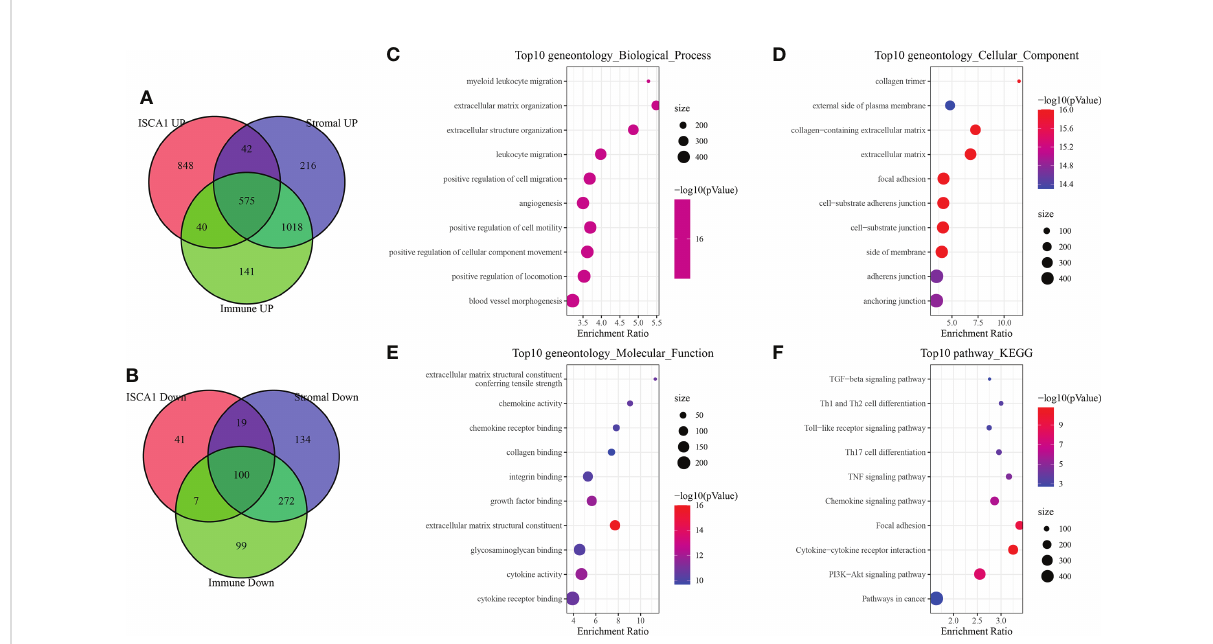
FIGURE 7 Immune-related differential gene analysis. (A) The intersection of up-regulated genes in ISCA1 , StromalScore, and ImmuneScore. (B) Intersection of down-regulated genes in ISCA1 , StromalScore, and ImmuneScore. (C – F) GO and KEGG enrichment analysis of differentially expressed genes in ISCA1 , StromalScore, and